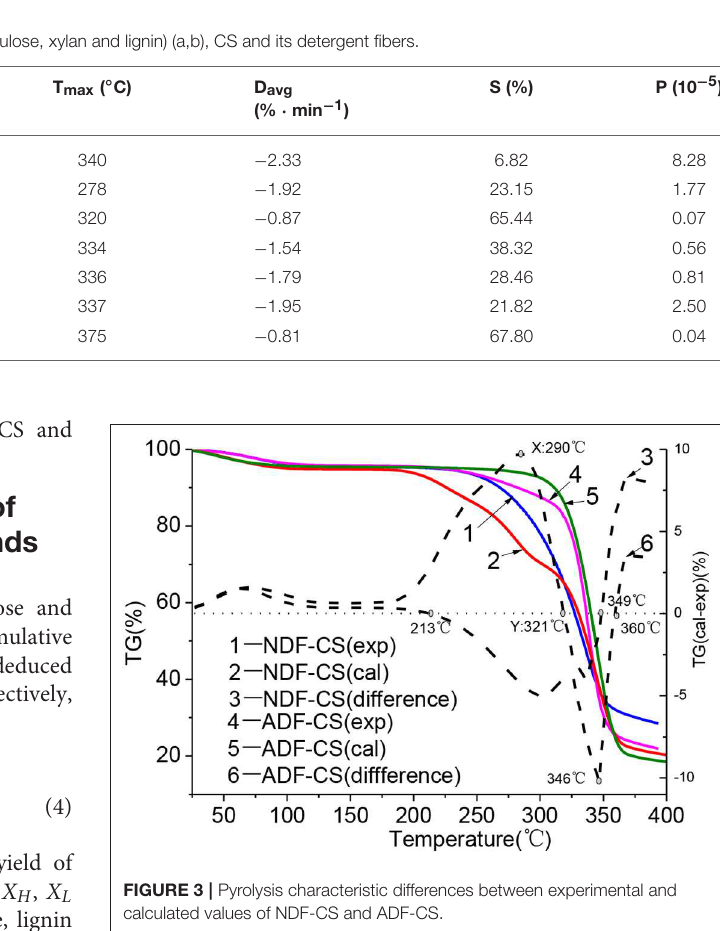
releasing slightly, so there is weaker impact on devolatilization by interaction of original